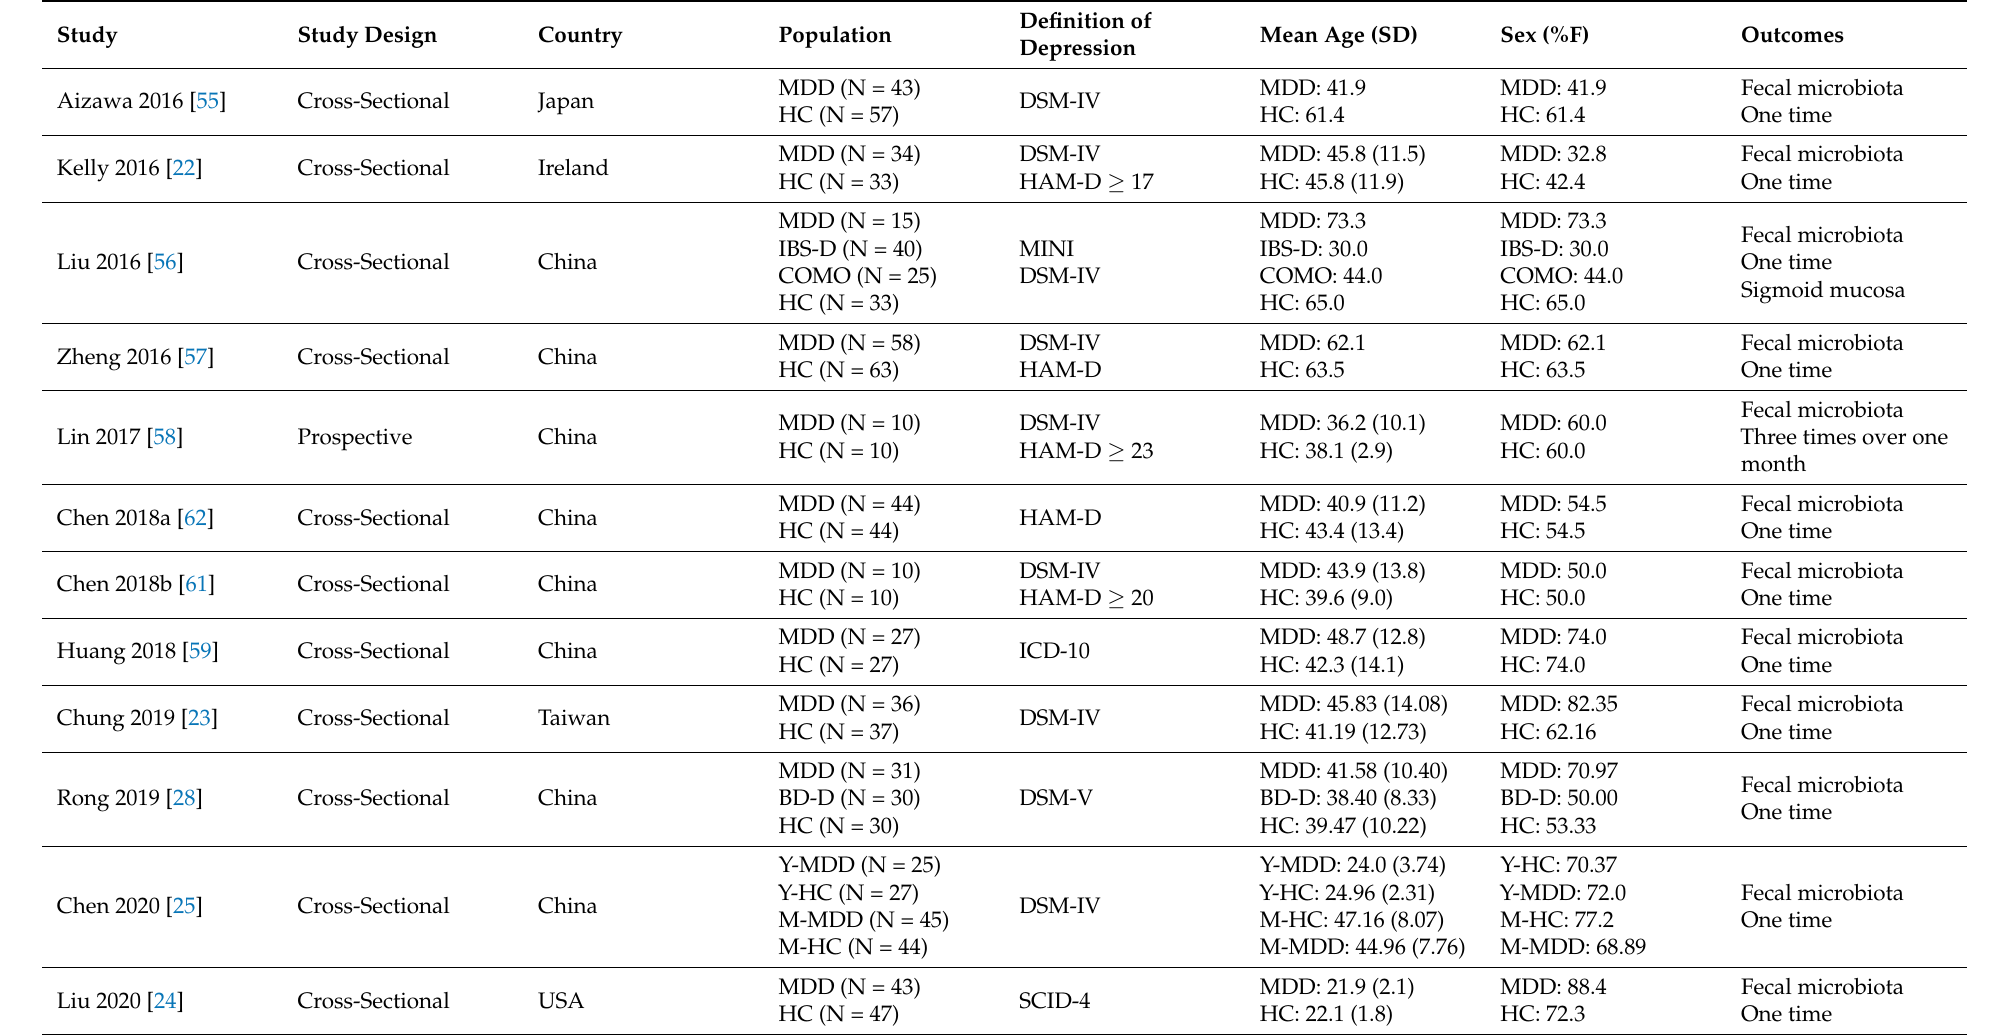
Table 1. Characteristics of observational studies from the past five years included in the systematic